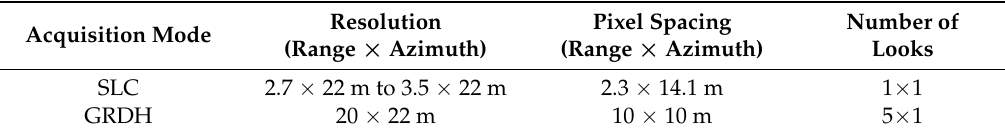
Table 1. Characteristics of Single Look Complex (SLC) and Ground Range Detected High Resolution (GRDH) products of the Interferometric Wide swathacquisition mode of Sentinel-1